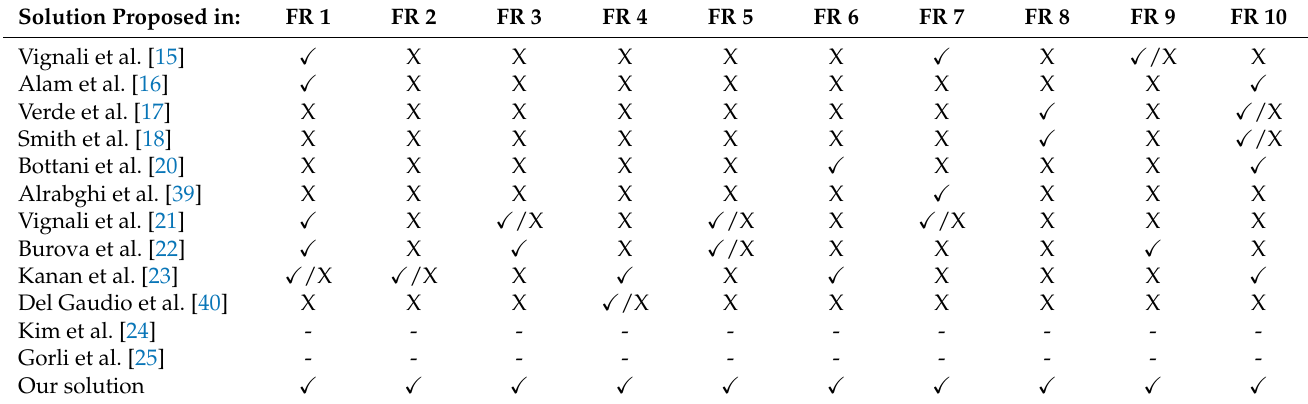
Table 2. Comparison through requirements